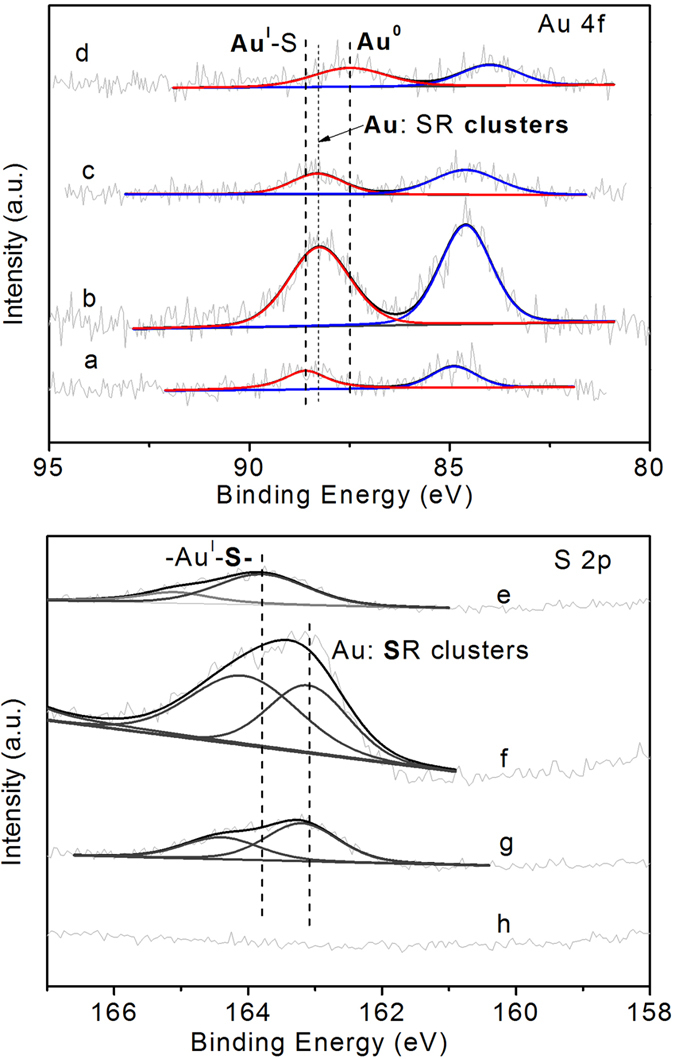
Au (4f) and S (2p) XPS spectra of catalysts (a,e) Au/MPTMS-SiO2-as, (b,f) Au/MPTMS-SiO2-BH4, (c,g) Au/MPTMS-SiO2-H2 and (d,h) Au/MPTMS-SiO2-cal.